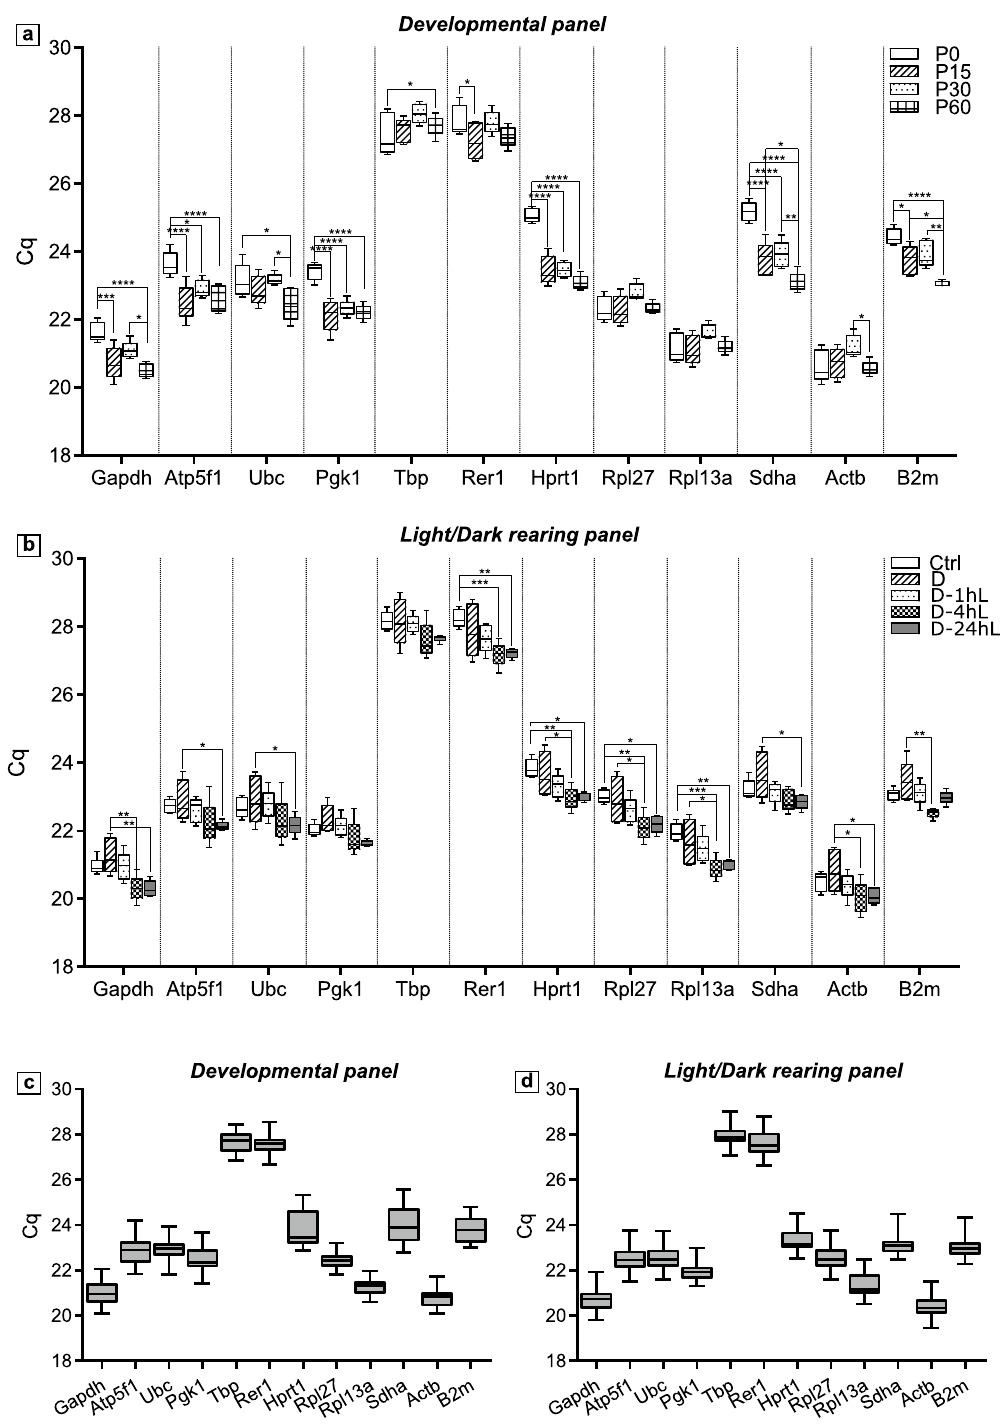
Figure 1. Descriptive statistics of 12 candidate reference genes in two sets of choroid plexus samples. Box-and- whisker plot showing Cq values of 12 housekeeping genes examined in the Developmental panel, displayed in different age groups ( a ) or displayed as all samples in the panel ( c ). Cq values of 12 housekeeping genes examined in the Light/Dark rearing panel, displayed in different rearing conditions ( b ) or displayed as all samples in the panel ( d ). Whisker indicates value range, the line inside the box was plotted at median value. (n = 5 mice per group (see Material and Method, Supplementary Table S1 for more details). Data is presented as Mean ± SD, adjusted p-values are indicated as * p ≤ 0.05, ** p ≤ 0.01, *** p ≤ 0.001, **** p ≤ 0.0001. Cq: quantification